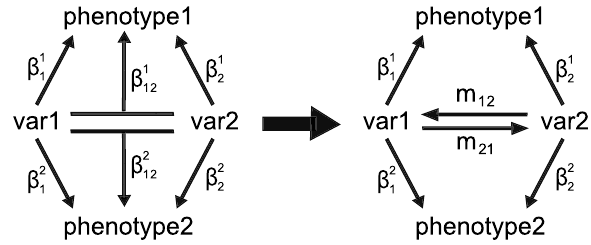
Figure 1. Overview of coefficient reparametrization for two phenotypes. On the left, main effect and interaction parameters for two variants ( var1 and var2 ) are derived from pairwise regressions ( b j The interaction coefficients are reparametrized as m 12 and m 21 on the right, which describe variant-to-variant influences that fit both phenotypes via indirect associations. For m 21 the source variant is var1 and the target variant is var2 , with the source and target reversed for m 12 . The intercept and possible covariate terms are not shown. Note ) are unchanged in the reparametrization. the main effects ( b 1 , b 2 , b 1 , b 2 1 1 2 2